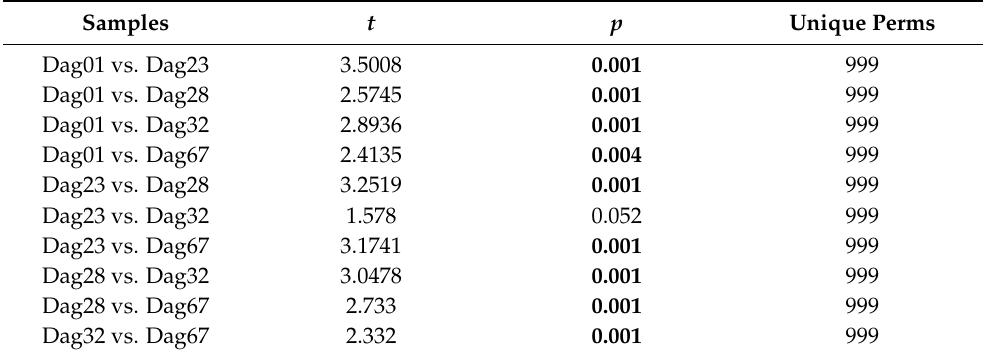
Table 5. Results of pair-wise PERMANCOVA tests with shell height (SH) removed. P values are significant levels estimated by permutations of residuals ( p < 0.05 are given in